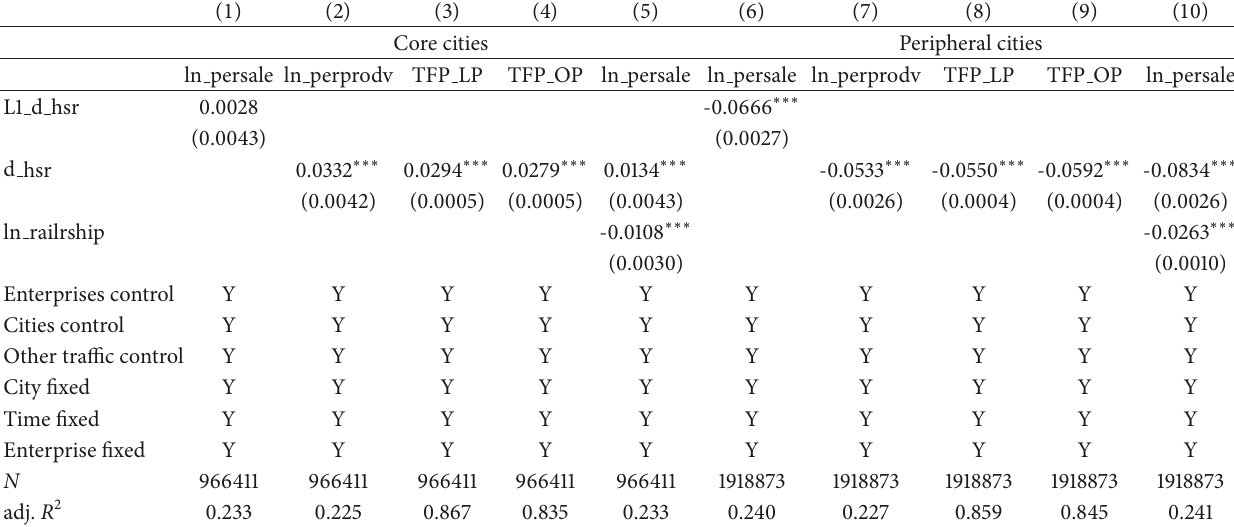
Table 12: Regression results of various robustness